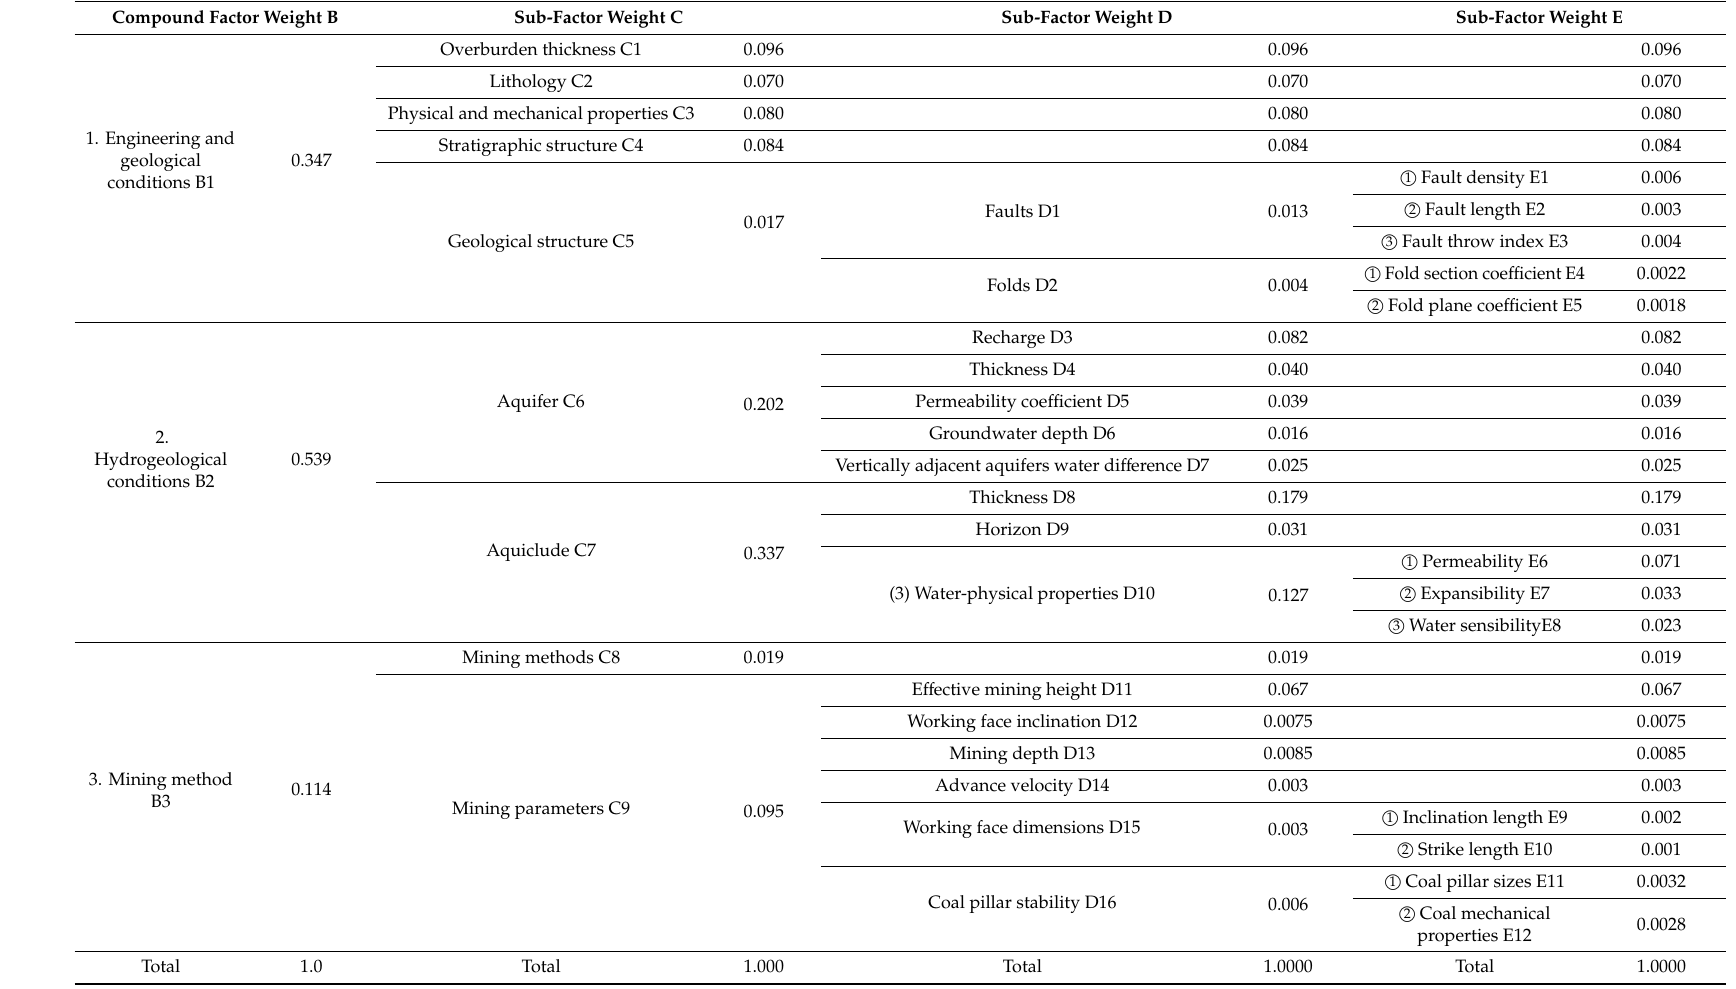
Table 1. Influencing factors and the weights of water-conserving